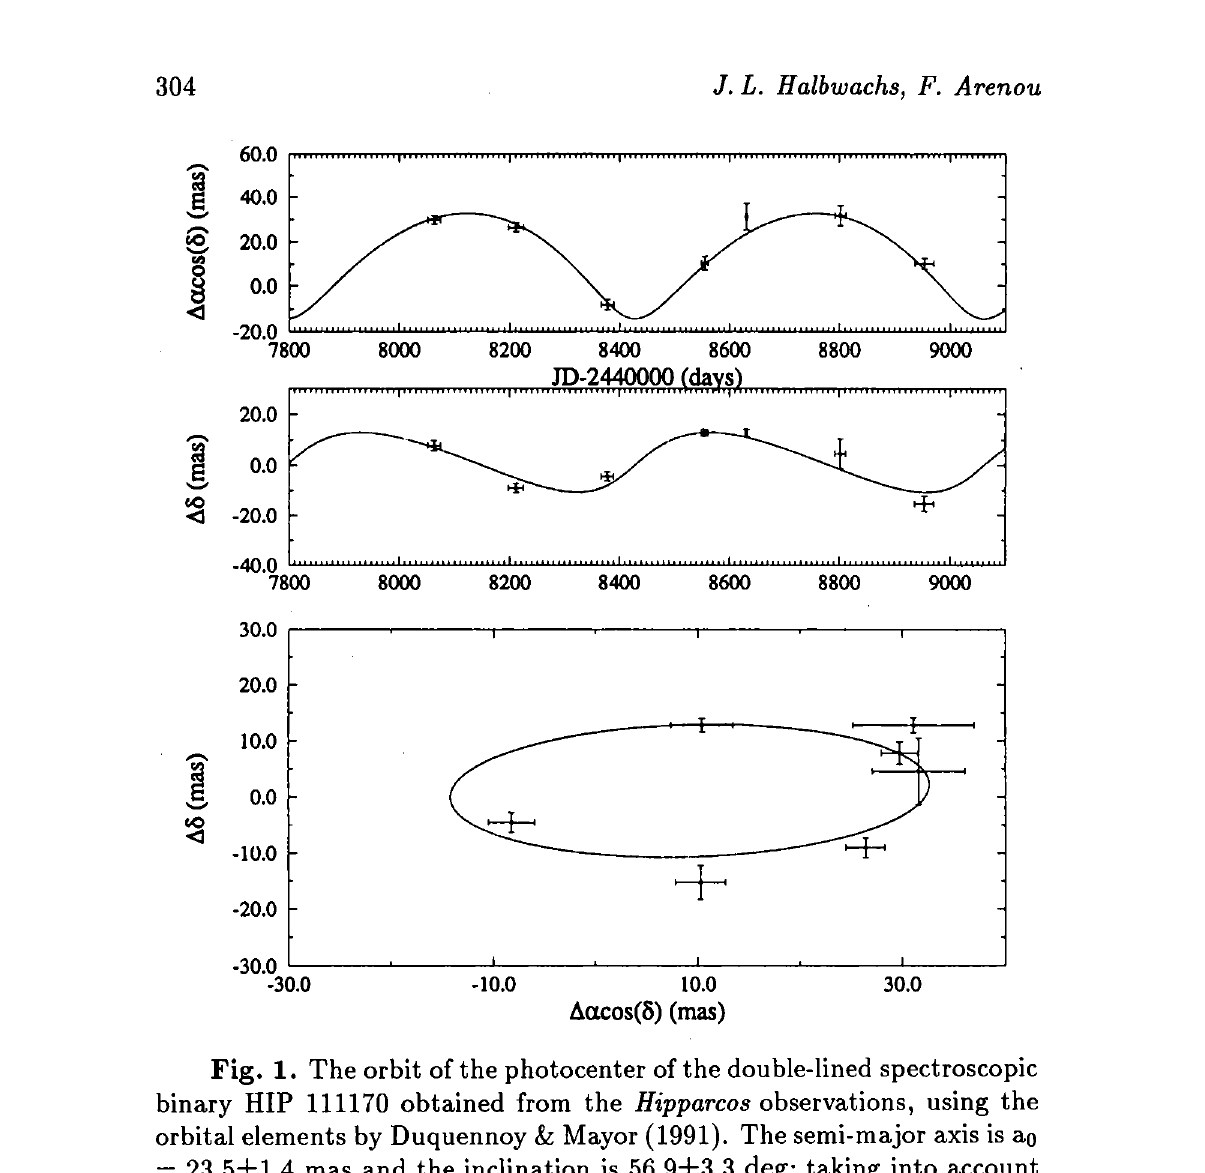
Fig. 1. The orbit of the photocenter of the double-lined spectroscopic binary HIP 111170 obtained from the Hipparcos observations, using the orbital elements by Duquennoy & Mayor (1991). The semi-major axis is ao = 23.5±1.4 mas and the inclination is 56.9±3.3 deg; taking into account the elements of the spectroscopic orbit and their errors, the masses of the components are Mi = 1.89±0.40 M© and M 2 = 1.04 ±0.20 A/©.